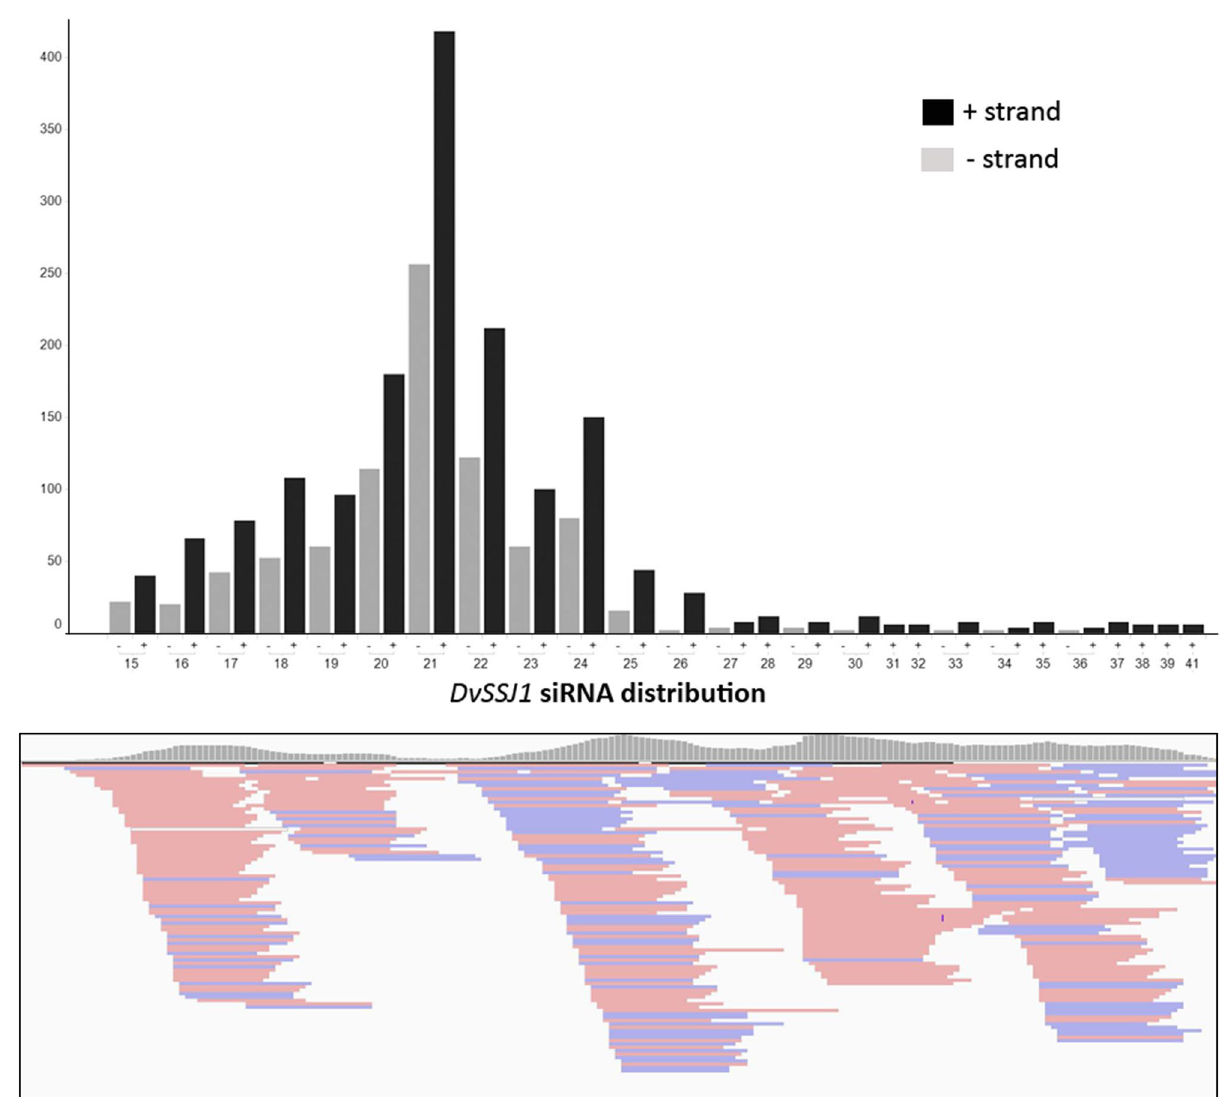
Figure 3. Analyses of DvSSJ1 siRNA expression in transgenic plants. Size distribution and strand orientation of DvSSJ1 small RNAs between 15 and 41 nucleotides were collected from root tissue under the control of the UBI promoter and showed in the top panel. Sense (red) and antisense (blue) of DvSSJ1 siRNAs were mapped to 210 bp DvSSJ1 fragment (Bottom panel). DvSSJ1 siRNA reads were visualized using Integrative Genomics Viewer software 2.8 (Broad Institute, Cambridge, MA, USA) (https ://softw are.broad insti tute.org/softw